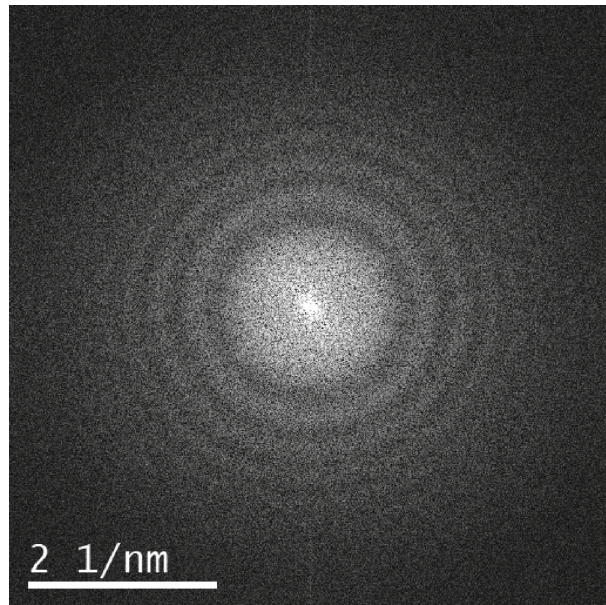
Figure 11: SAED pattern of hydrothermal channel obtained from the yellow square in Figure 6(a), indicating that the hydrothermal channel is amorphous